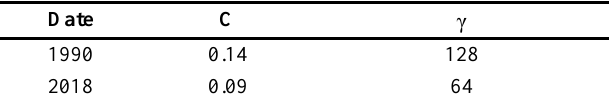
Table 3. RBF kernel parameters